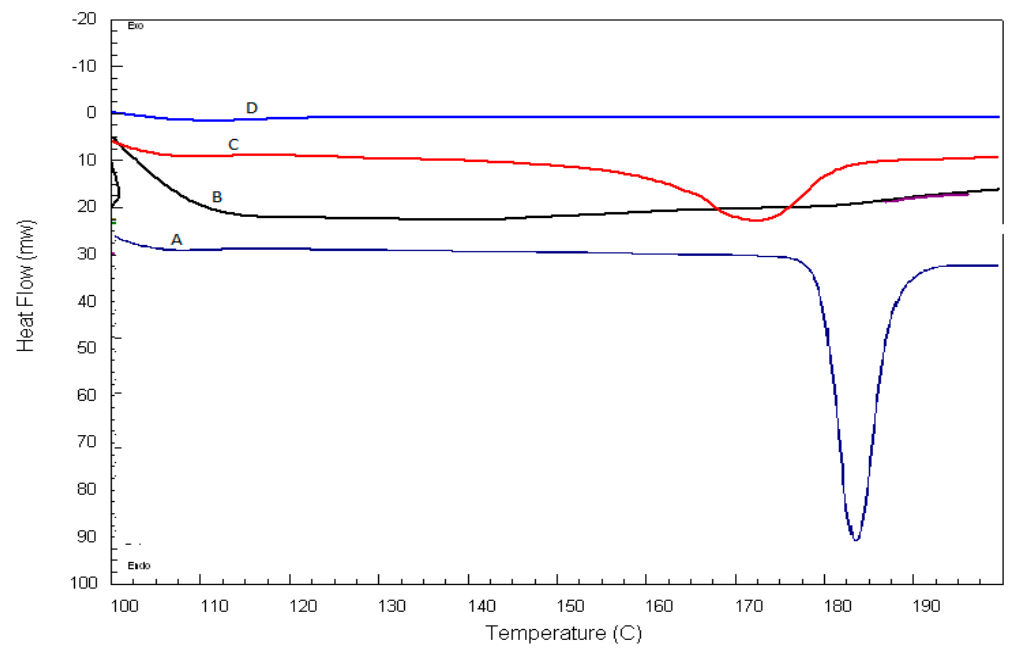
Figure 4. DSC thermograms of A: Pure QTF, B: Lecithin, stearic acid, and Pluronic F-127 mixture, C: Lecithin, stearic acid, Pluronic F-127, and QTF, and D: the best formula.